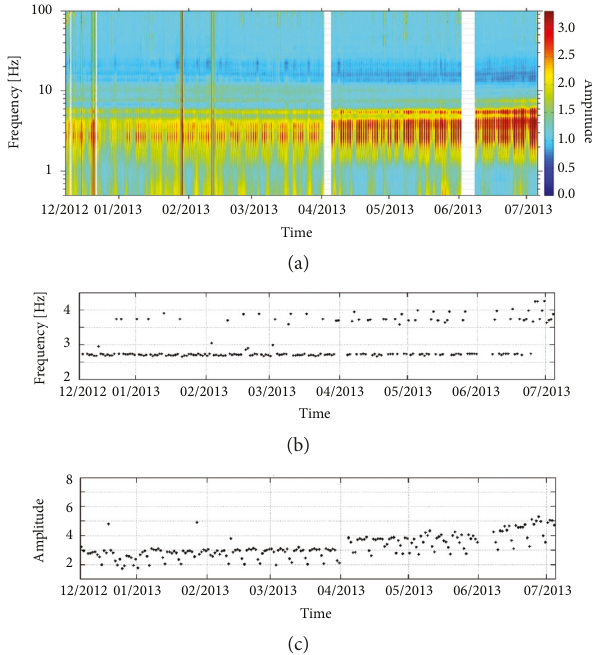
Figure 6: Near here: (a) The TOR4 HVSR amplitude, (b) the peak frequency distribution, and (c) the peak amplitude distribution over the whole monitoring